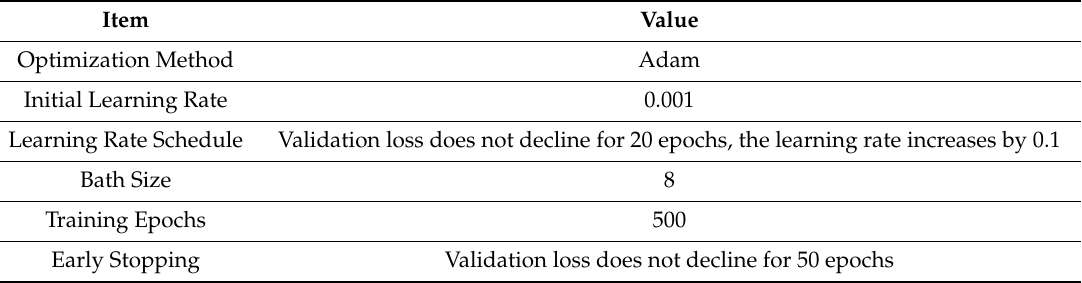
Table 4. Other network hyperparameters for enhanced YOLOv3 model